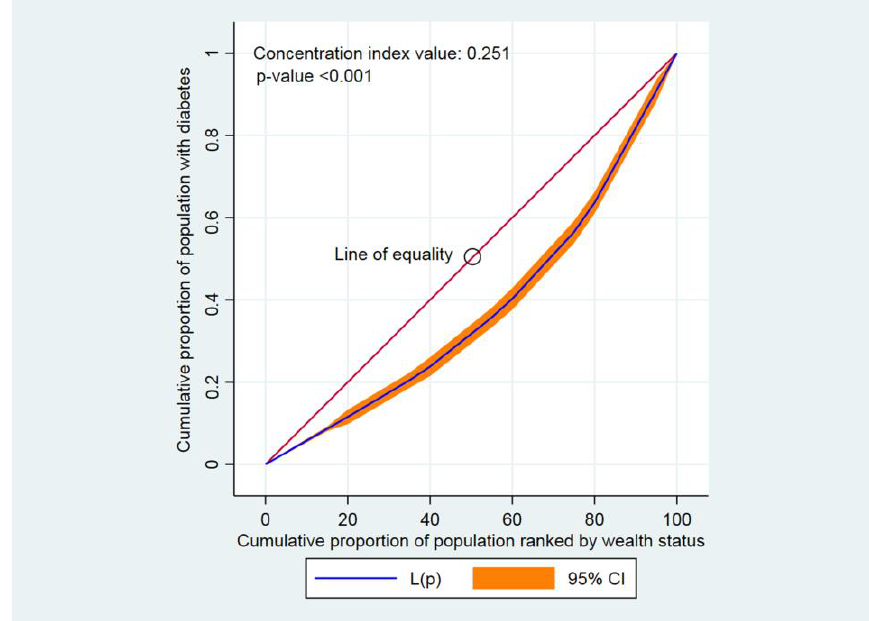
Figure 1. Concentration curve for diabetes. Here, CI denotes confidence interval.